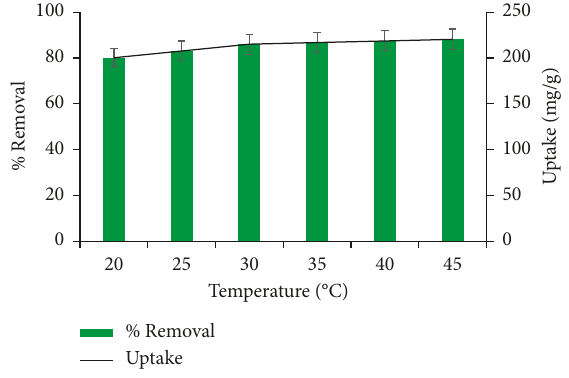
Figure 3: Temperature effects on RO16